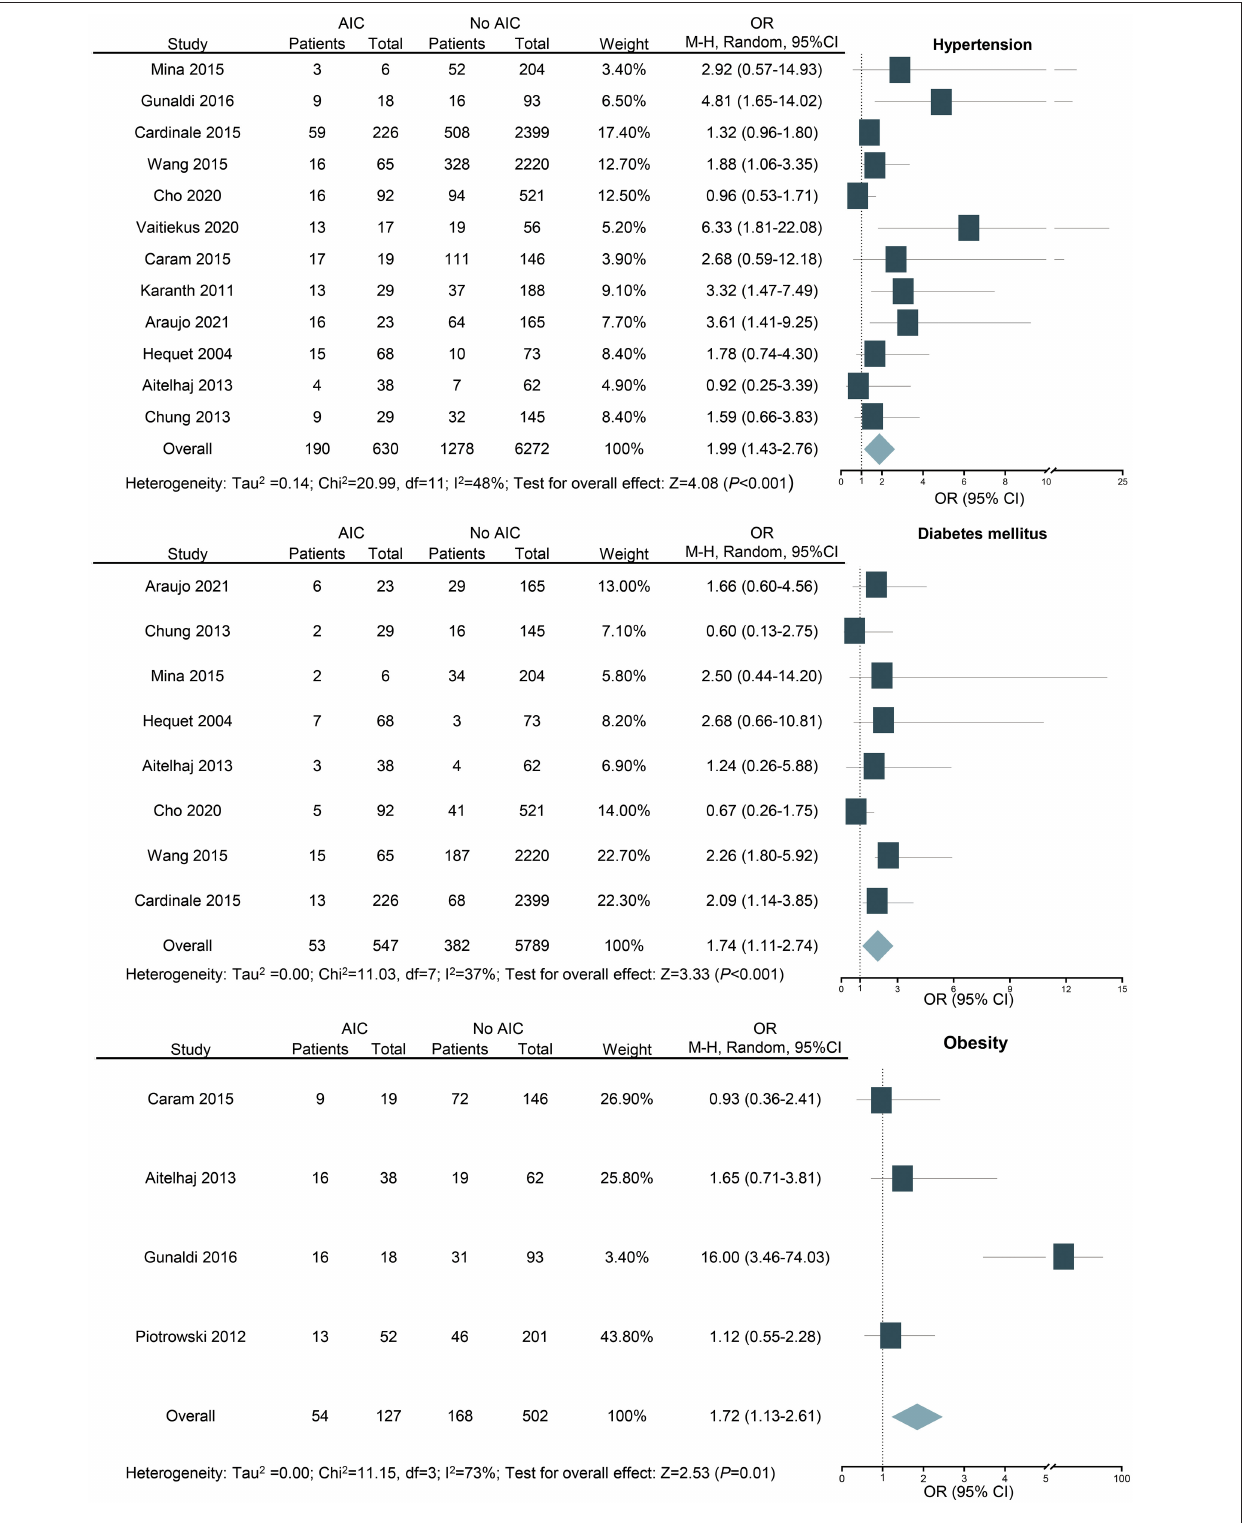
FIGURE 4 | Forest plot for the effects of hypertension, diabetes mellitus, and obesity on the risk of anthracycline-induced cardiotoxicity. CI, confidence intervals; OR, odd ratios.